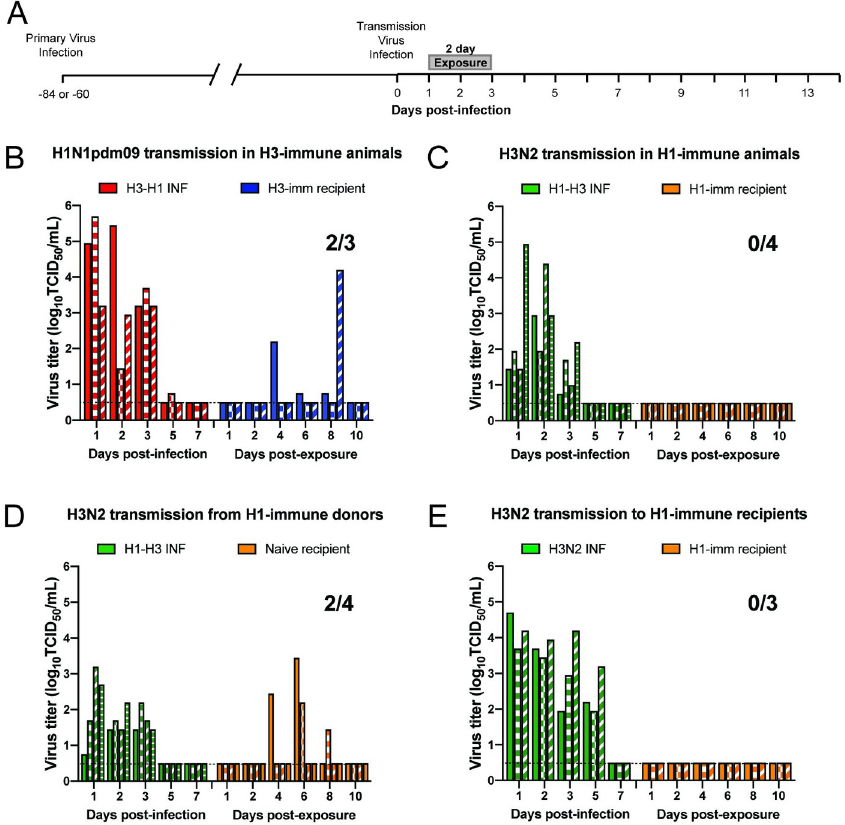
Fig 2. Pre-existing heterosubtypic immunity blocks H3N2 transmission but not H1N1pdm09 transmission. (A) Schematic of experimental procedure, gray bars depict 2-day exposure time. (B) All donor and recipient animals were infected with A/Perth/16/2009 (H3N2) virus 60 days prior to H1N1pdm09 (A/CA/07/2009) transmission. Donor animals are denoted as H3-H1 INF, and recipient animals are ‘H3-imm’. (C) All donor and recipient animals were infected with A/CA/07/2009 (H1N1pdm09) virus 84 days prior to H3N2 (Perth/16/2009) transmission. Donor animals are denoted as H1-H3 INF, and recipient animals are ‘H1-imm’. The contribution of donor and recipient immunity was tested separately for A/Perth/16/2009 (H3N2) transmission. Donors only (D) or recipient only (E) had pre- existing immunity to A/CA/07/09 H1N1pdm09. Donor animals are denoted as H1-H3 INF or H3N2 INF (no prior immunity), and recipient animals are either ‘na ï ve’ to indicate no prior immunity or ‘H1-imm’. Each bar represents an individual animal. Limit of detection is denoted by a dashed line.